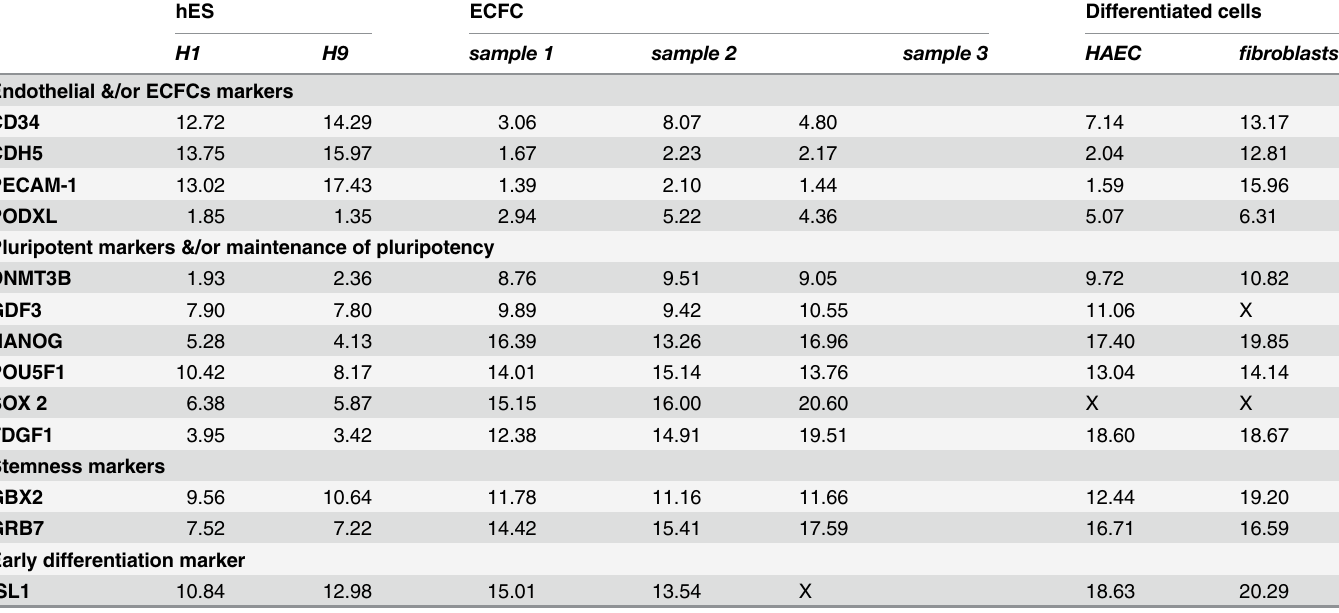
Table 1. Stemness genes expression array. Data are expressed as Δ Ct. Transcript levels were normalized to GAPDH transcript level. Genes whose detection threshold is over 35 cycles are considered as not expressed and symbolized by “ X ” . hES ECFC Differentiated cells H1 H9 sample 1 sample 2 sample 3 HAEC fi